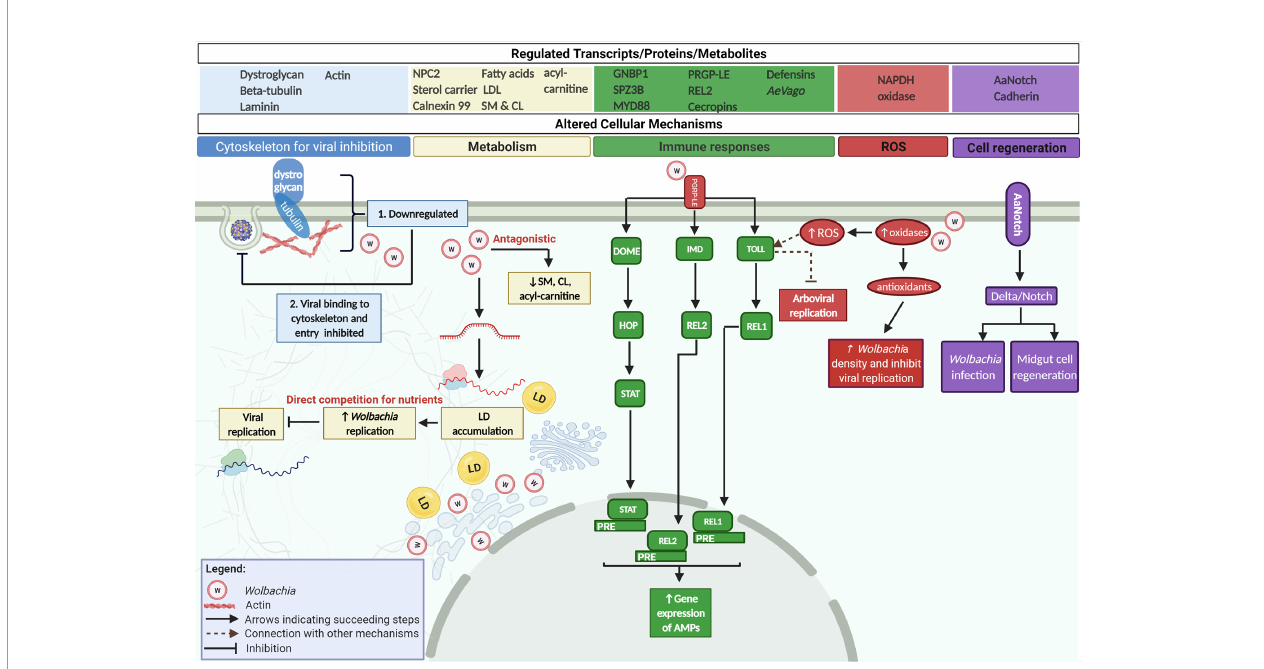
FIGURE 3 | Wolbachia interferes with Arboviral life cycle by interfering with host factors and strengthening host antiviral mechanisms. Wolbachia blocks DENV, ZIKV, and CHIKV by interfering with the same cellular mechanisms arboviruses control in Ae. aegypti. First, Wolbachia downregulates cytoskeletal structures that directly bind to arboval proteins for host cell infection. Next, Wolbachia competes for host ’ s lipid/cholesterol for its replication making this nutrient insuf fi cient for the virus. Wolbachia can also deplete lipids namely sphingomyelins (SM), cardiolipins (CL), and acyl-carnitine that are essential for viruses. Wolbachia also strengthens the host ’ s immunity by activating Toll, IMD, and JAK/STAT via PGRP-LE. The endosymbiont further induces ROS release in the presence of an arbovirus by increasing oxidases in the cell. This inhibits viral replication and in turn, stimulates the Toll pathway. Wolbachia then counteracts the release of antioxidants to sustain its infection within the host. Lastly, Wolbachia upregulates receptor gene, AaNotch in Ae. aegypti . This receptor gene signals the Delta/Notch pathway. Consequently, the adhesion molecule Cadherin is increased strengthening the host ’ s reproductive ability and ensures maintenance of Wolbachia. Delta/Notch also promotes the regeneration of the midgut epithelia to prevent systemic viral